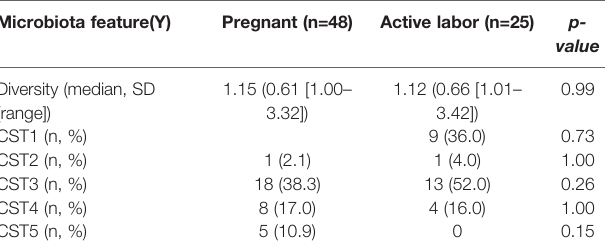
TABLE 2 | Microbiota diversity and community state types